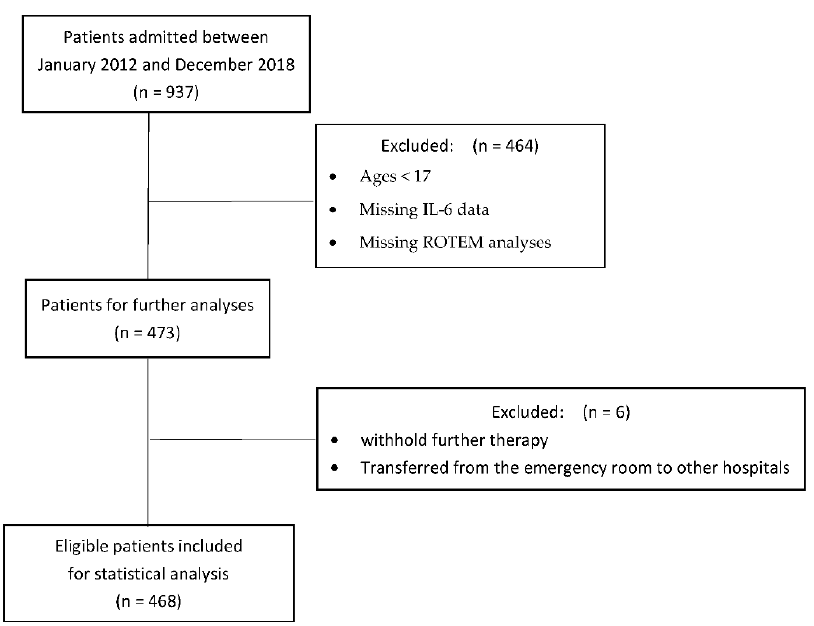
Figure 1. Flow chart of included and excluded